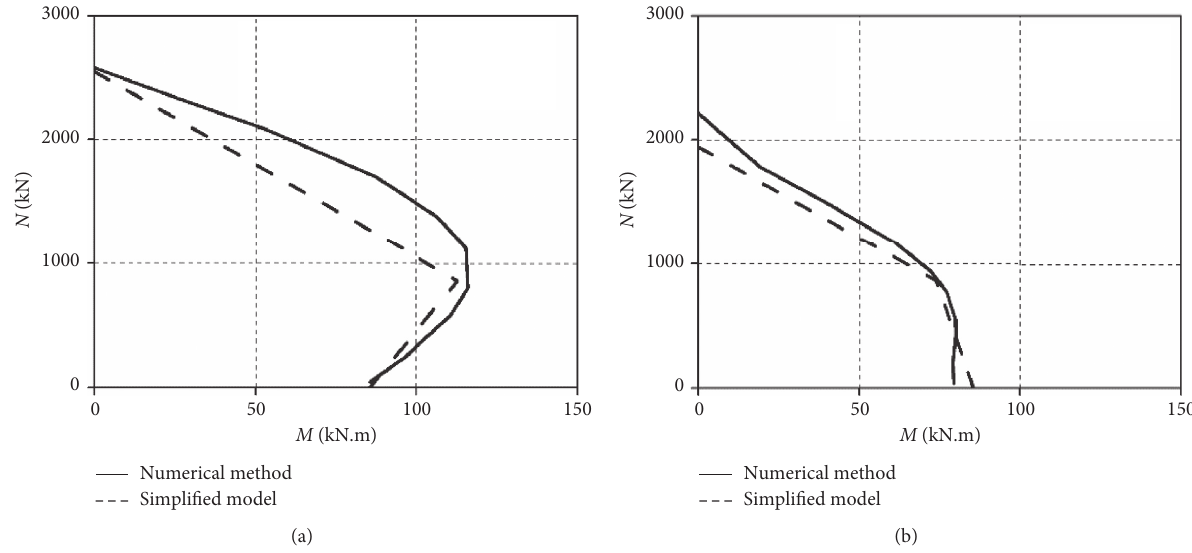
Figure 25: Verification of simplified N-M resistance model of columns under different slenderness ratios. (a) λ � 13.3. (b) λ � 60.